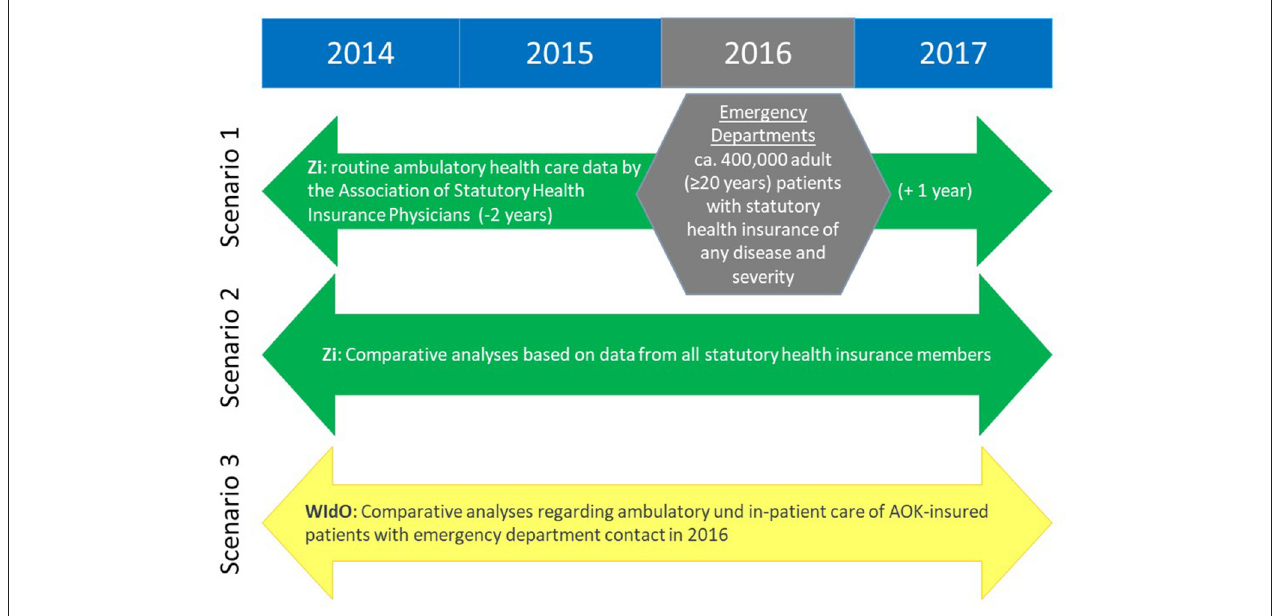
FIGURE 1 | Project scenarios 1–3 using the evaluation of different data